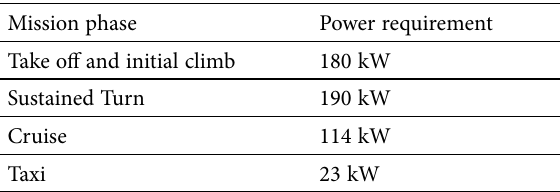
Table 1. Power requirements for the reference aircraft